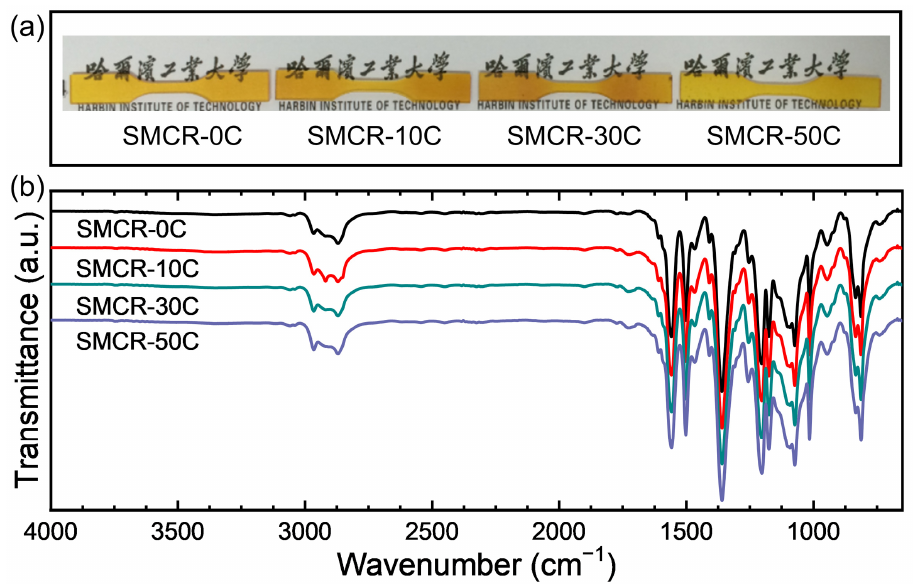
Figure 1. ( a ) Photographs of SMCR without vacuum thermal cycling (SMCR-0C) and after 10 (SMCR-10C), 30 (SMCR-30C), and 50 (SMCR-50C) vacuum thermal cycles; ( b ) FTIR spectra of SMCR before and after vacuum thermal cycling.